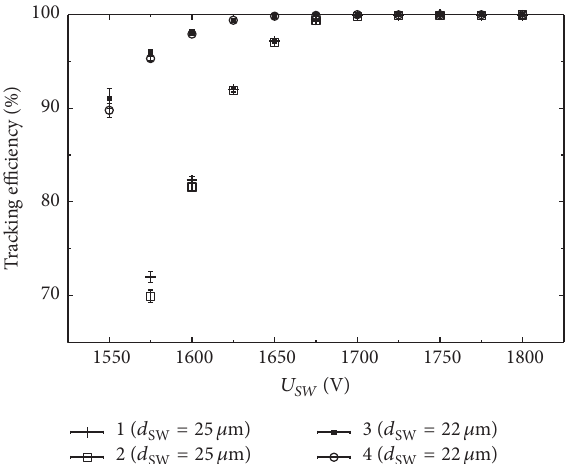
Figure 4: Tracking efficiency of the detector layers 1–4 as a function of the anode high voltage. A very clear plateau is observed, which extends from 1700V to 1800V. The single detector layers were built with 22 and 25 𝜇 m diameter anode wires as